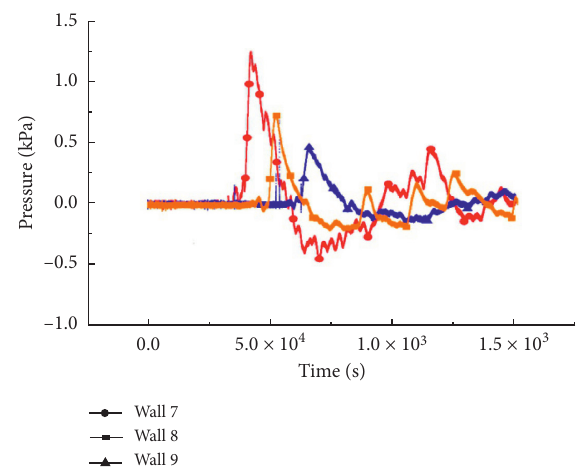
Figure 6: Comparison of overpressure–time curves of Walls 7, 8, and